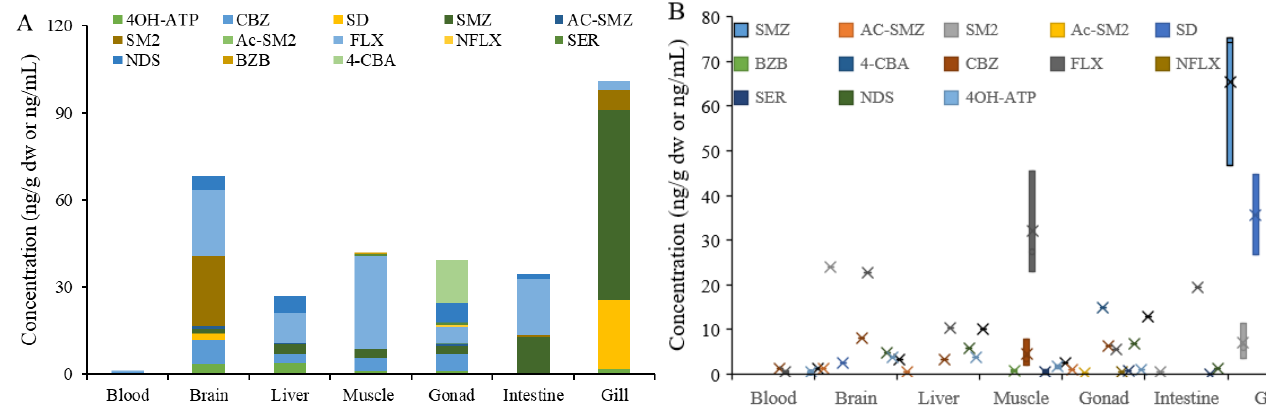
Figure 8. Accumulation of pharmaceutical metabolites and their parents in different fish tissues, ( A ) total concentration, and ( B ) concentration distribution.